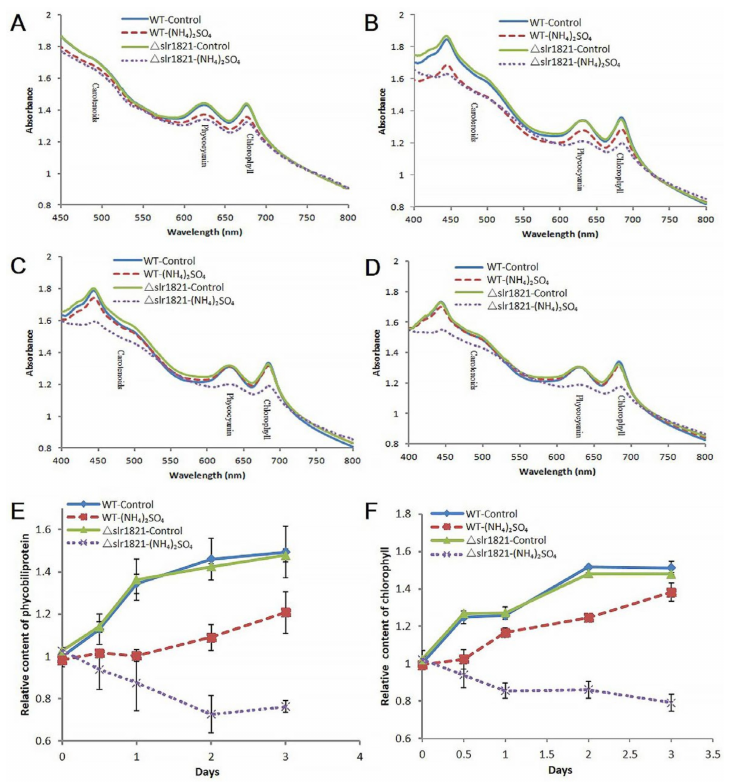
Figure 6. Defective photosystem in ∆ slr1821 upon NH 4+ stress. (A)-(D). The whole cell absorption spectra of WT and ∆ slr1821 with or without 15 mM (NH 4 ) 2 SO 4 at the first ( A ), second ( B ), third ( C ) and fourth ( D ) days, respectively. ( E ) The relative content of phycobiliprotein in WT and ∆ slr1821 with or without 15 mM (NH 4 ) 2 SO 4 during the first three days. Relative content was data normalized to WT control in day 0 setting as 1. ( F ) The relative content of chlorophyll in WT and ∆ slr1821 with or without 15 mM (NH 4 ) 2 SO 4 during the first three days. Relative content was data normalized to WT control in day 0 setting as